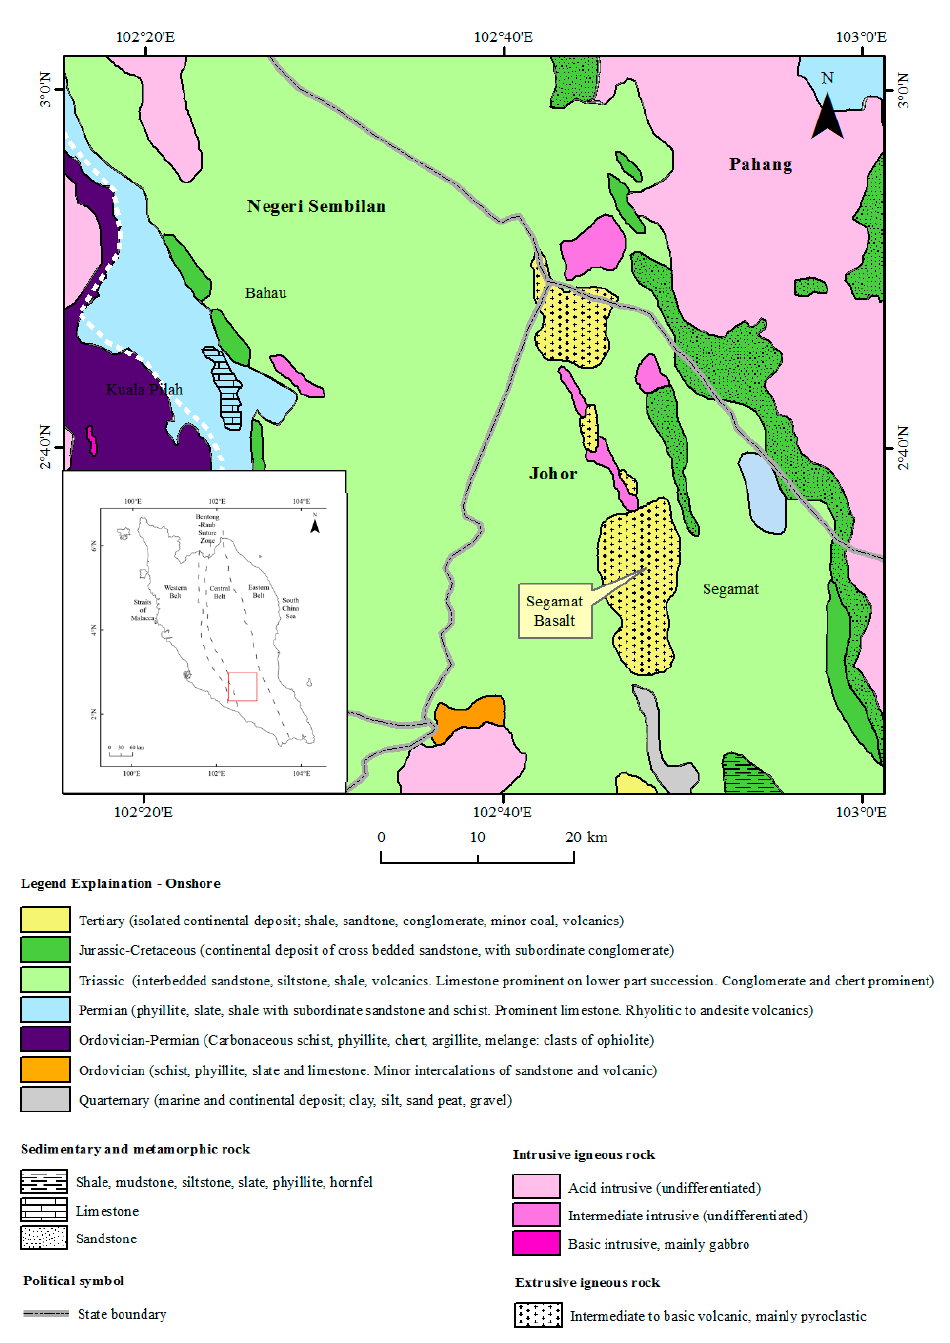
Figure 1. Geological map of Segamat basalt modified from Ng et al. [34].